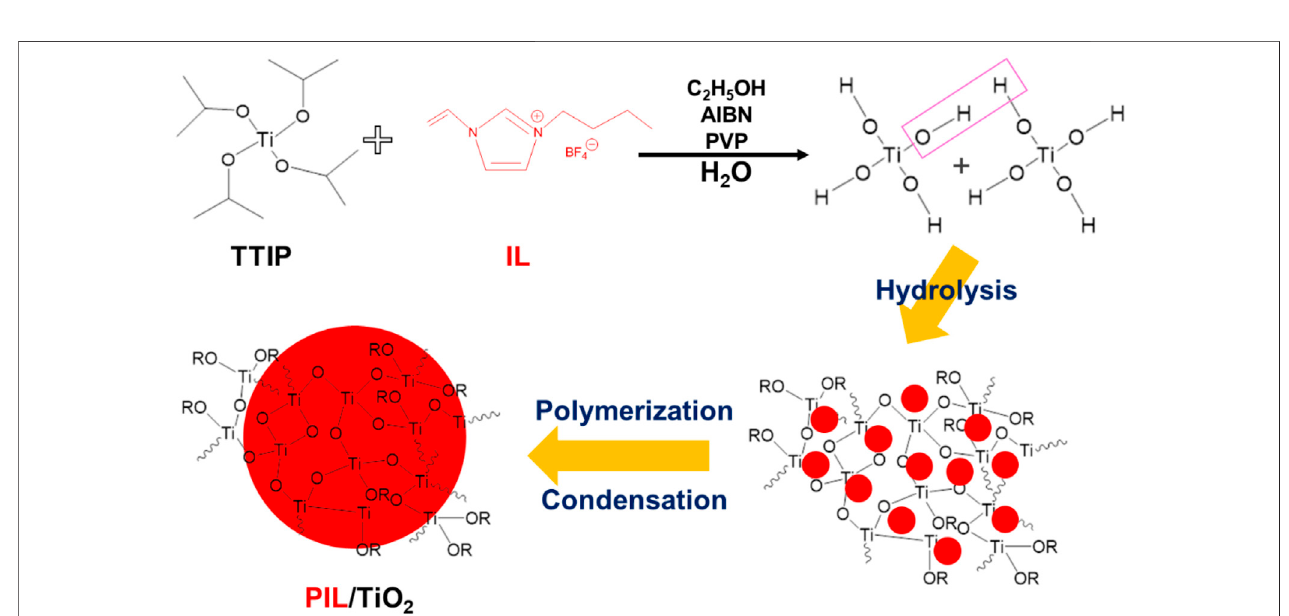
SCHEME 1 | Fabrication process of the PIL/TiO 2